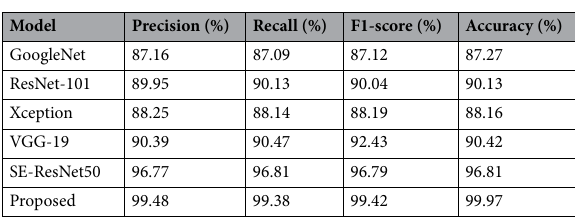
Table 4. Comparative analysis of our approach with the base